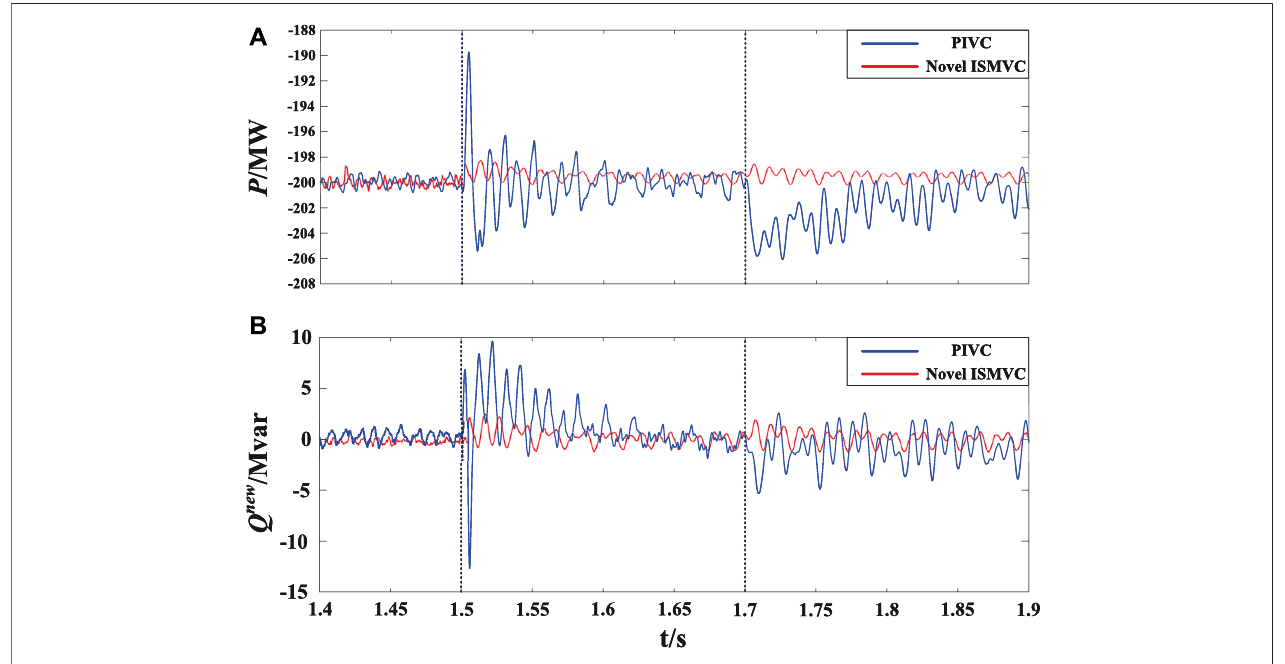
FIGURE8| SimulationresultsofdynamicpowerresponsesandrobustnessusingthePIVCandnovelISMVC, (A) activepoweroutputbyMMC 2 usingthePIVCand novel ISMVC, (B) ERP output by MMC 2 using the PIVC and novel ISMVC.